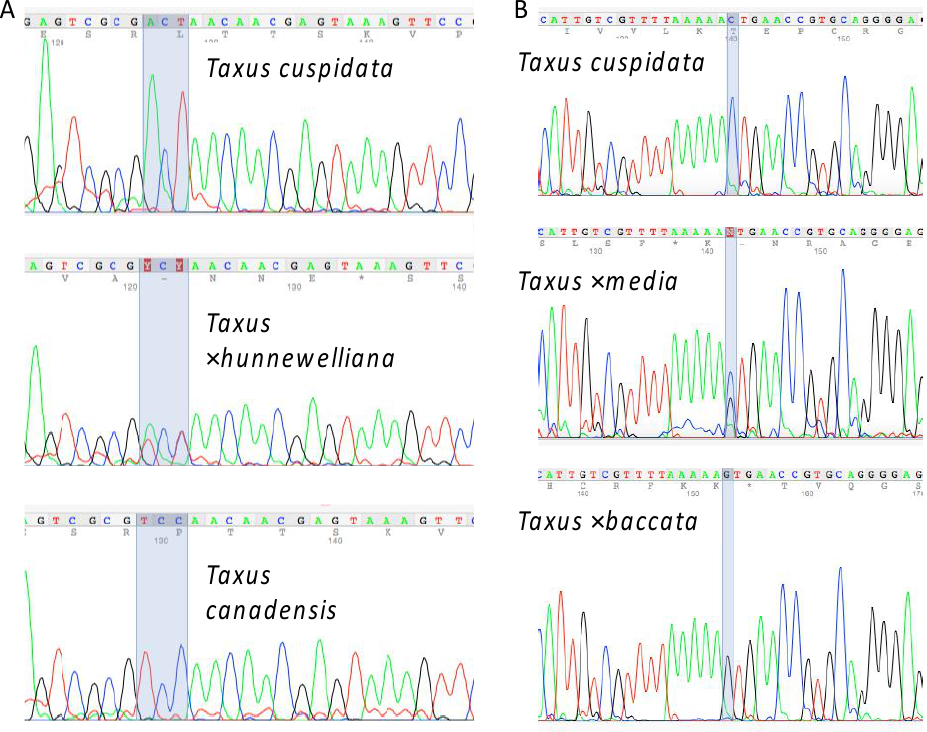
Figure 5. Sequence heterogeneity in T. × hunnewelliana ( A ) and T. × media ( B ) and corresponding sequences in their putative parental species. Taxus × hunnewelliana = T.cuspidata × T. canadensis ; Taxus × media = T. cuspidata × T. baccata .